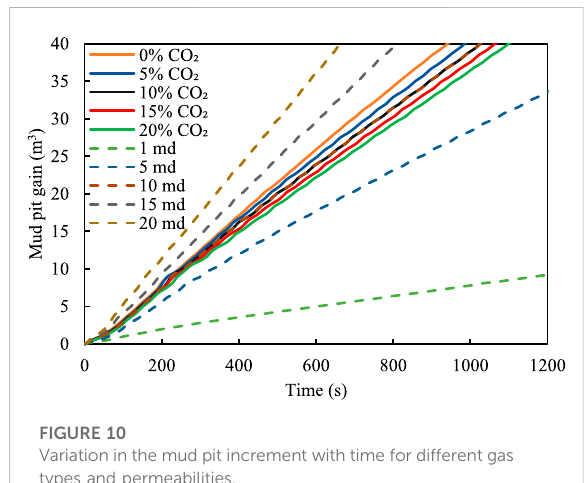
FIGURE 8 Relationship between free gas integral number and well depth for different time durations.